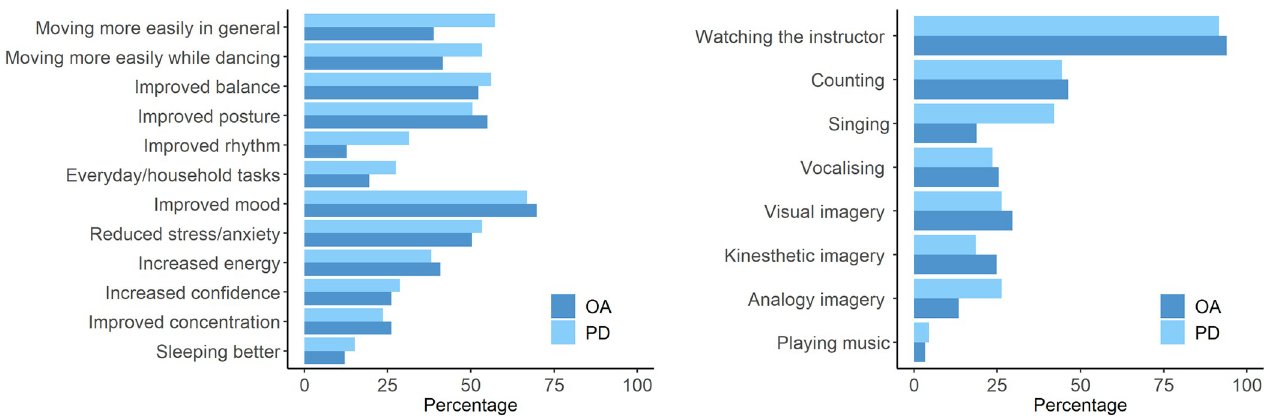
Fig 2. Outcomes of at-home dance (left; percentage of participants reporting effects) and strategies used during dance (right; percentage of participants engaging in each strategy) as reported by older adults (OA) and people with